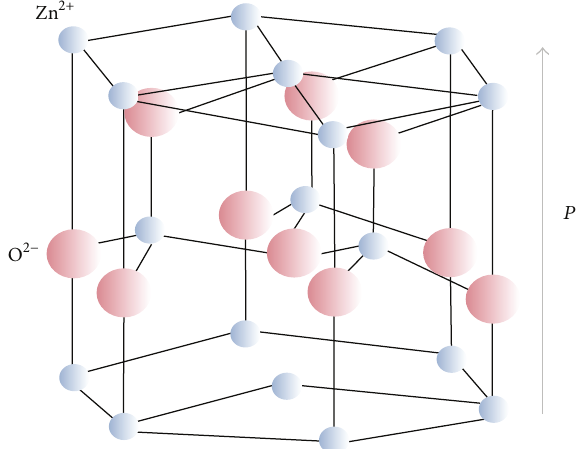
Figure 1: Hexagonal structure of wurtzite zinc